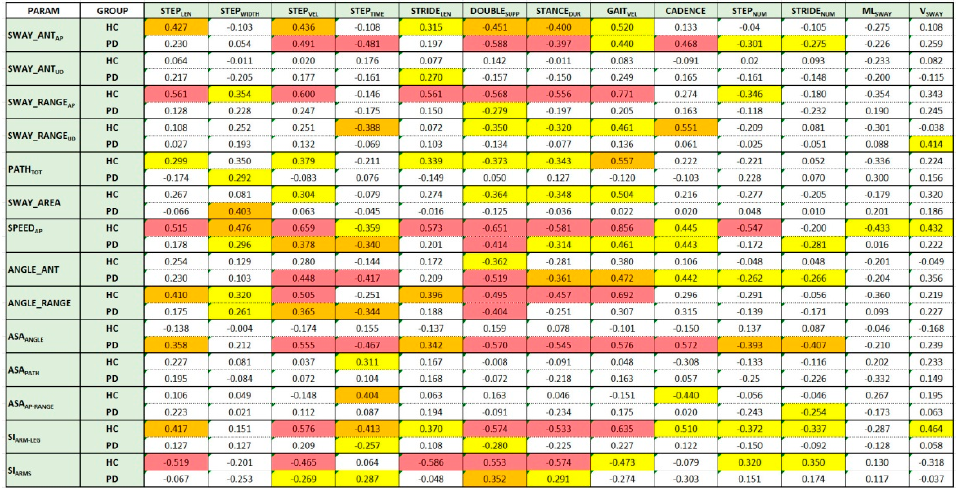
Figure 4. Spearman’s correlation coefficients between parameters for HC and PD groups. Colored boxes indicate the level of significance: yellow ( p < 0.05); orange ( p < 0.01); red ( p < 0.001).